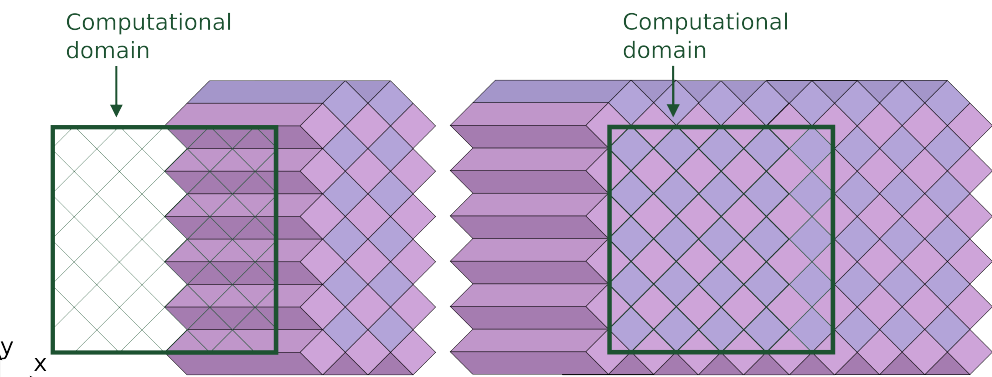
Figure 9. After boundary prisms are processed, in some cells of the computation domain, the field has the values of the Nt -th iteration step; in some cells, the field has its initial values; and other cells have values on the time step from zero to Nt ( left ). After all stages are processed, all field values reach the Nt -th time step ( right